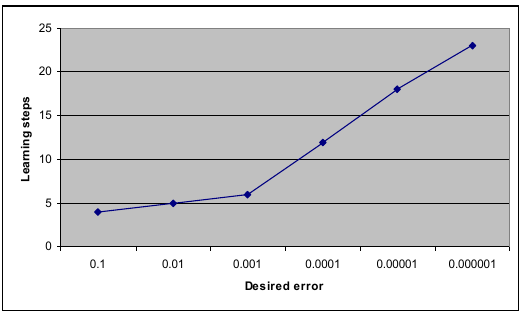
Figure 7. Learning step vs. desired error for quant = 4 and  =